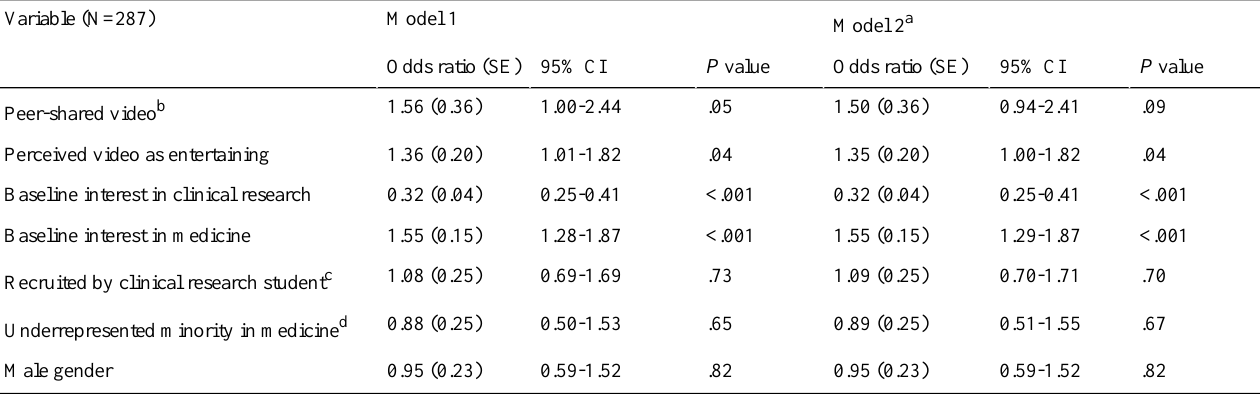
Table 2. Ordinal logistic regression testing the association between predictors and change in clinical research